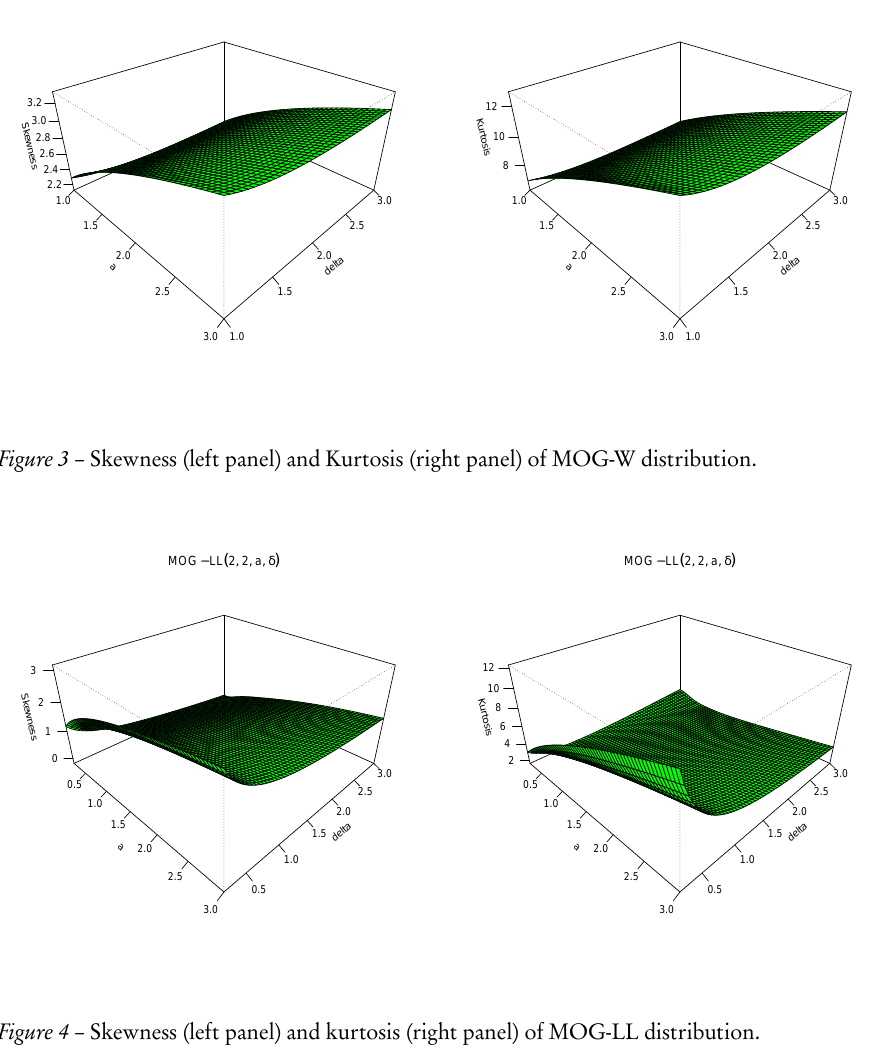
( t ) , of X can be expressed from (11) s